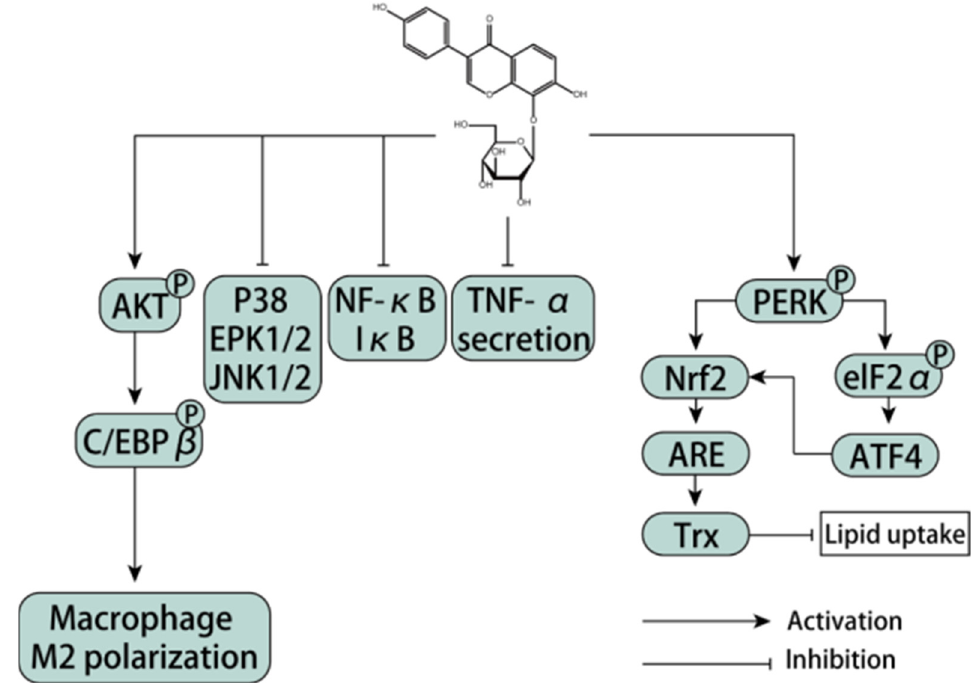
Figure 5. The mechanism of puerarin on immune